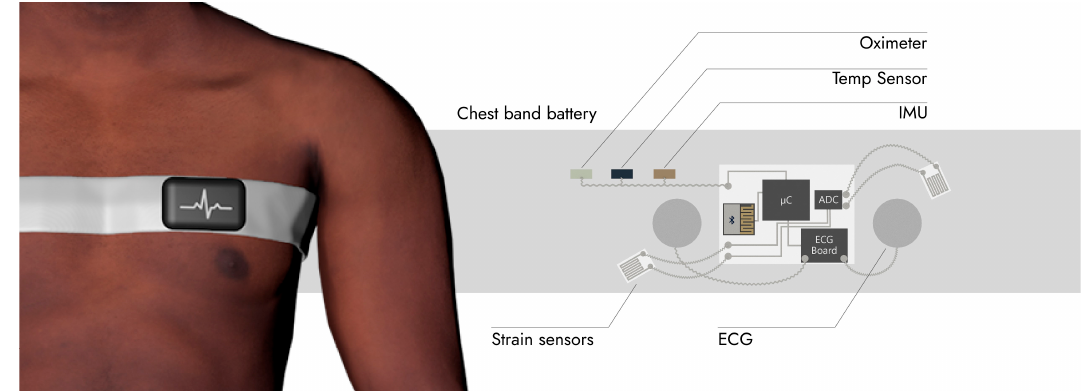
Figure 13. Schematics of the chest and circuit with the sensor implementation, the main chip would be the Bluetooth and µC board. With ECG board, and the multiple sensors included in the chest band, which has a battery integrated.